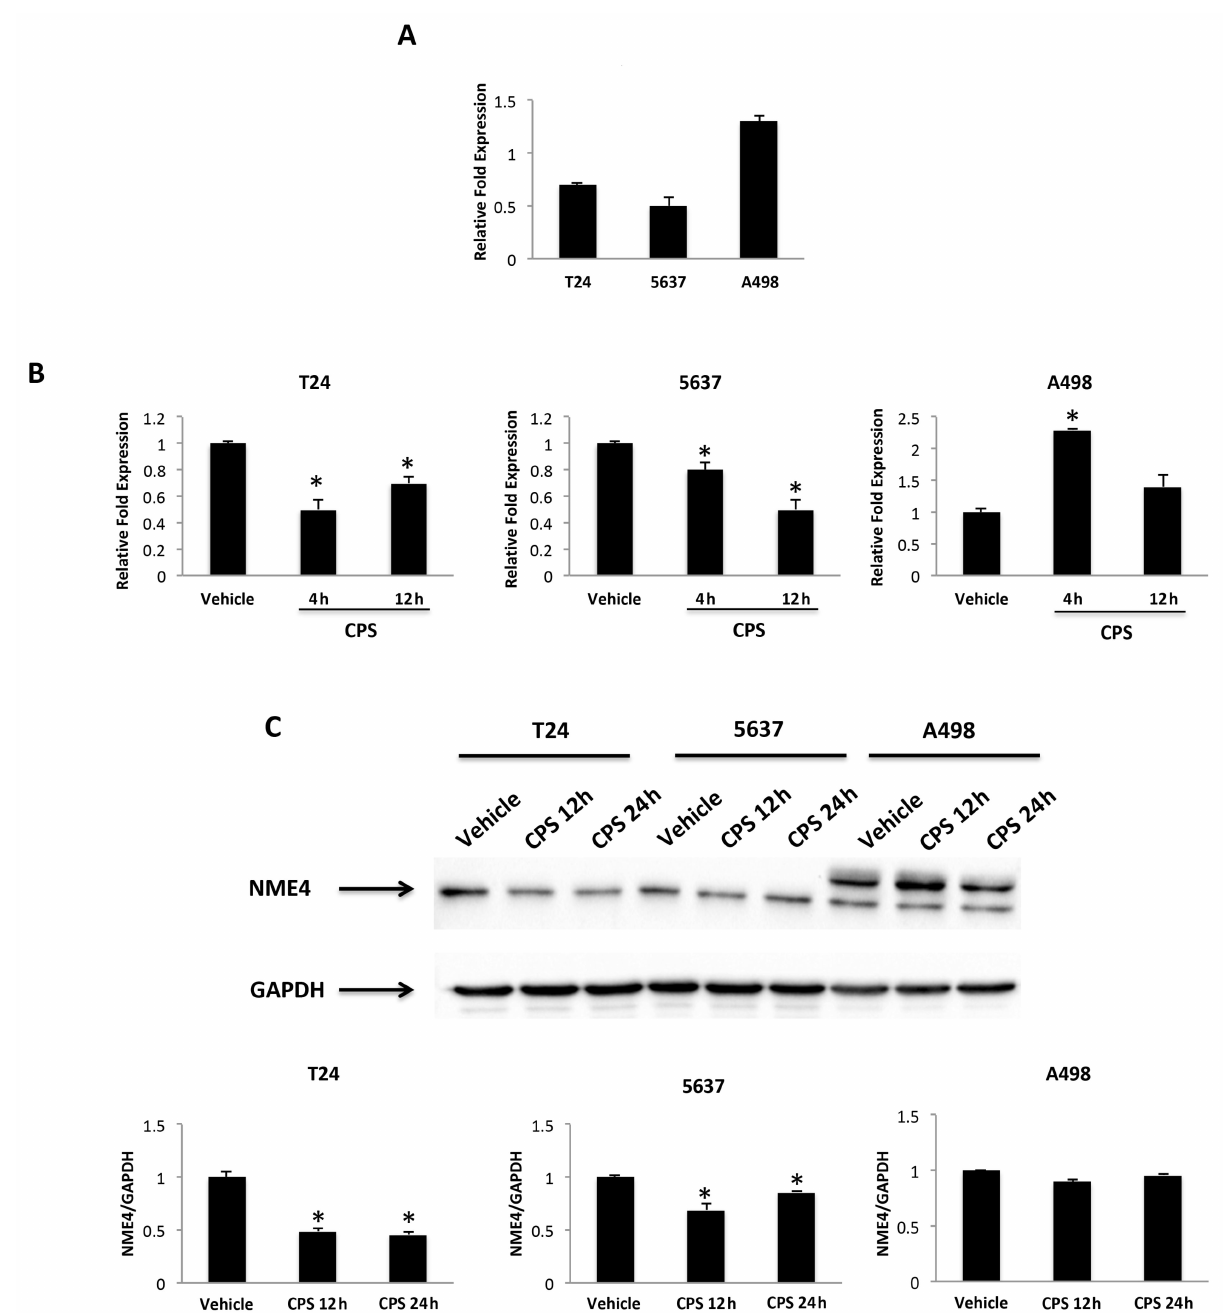
Figure 7. CPS treatment influences NME4 expression. ( A ) Relative NME4 mRNA expression in T24, 5637 and A498 cell lines was evaluated by qRT-PCR. NME4 mRNA levels were normalized for GAPDH expression. Data are expressed as mean ± SD. ( B ) Relative NME4 mRNA expression in T24, 5637 and A498 cell lines treated with CPS for 4 and 12 h was evaluated by qRT-PCR. NME4 mRNA levels were normalized for GAPDH expression. Data are expressed as mean ± SD; * p < 0.05 vs. vehicle-treated cells. ( C ) Western blot analysis of NME4 protein levels in T24, 5637 and A498 cell lines treated with CPS for 12 and 24 h. Blots are representative of one of three separate experiments. NME4 densitometry values were normalized to GAPDH, used as the loading control. Data are expressed as mean ± SD; * p < 0.05 vs. vehicle-treated cells. Detailed information about the Western blotting can be found in Figure